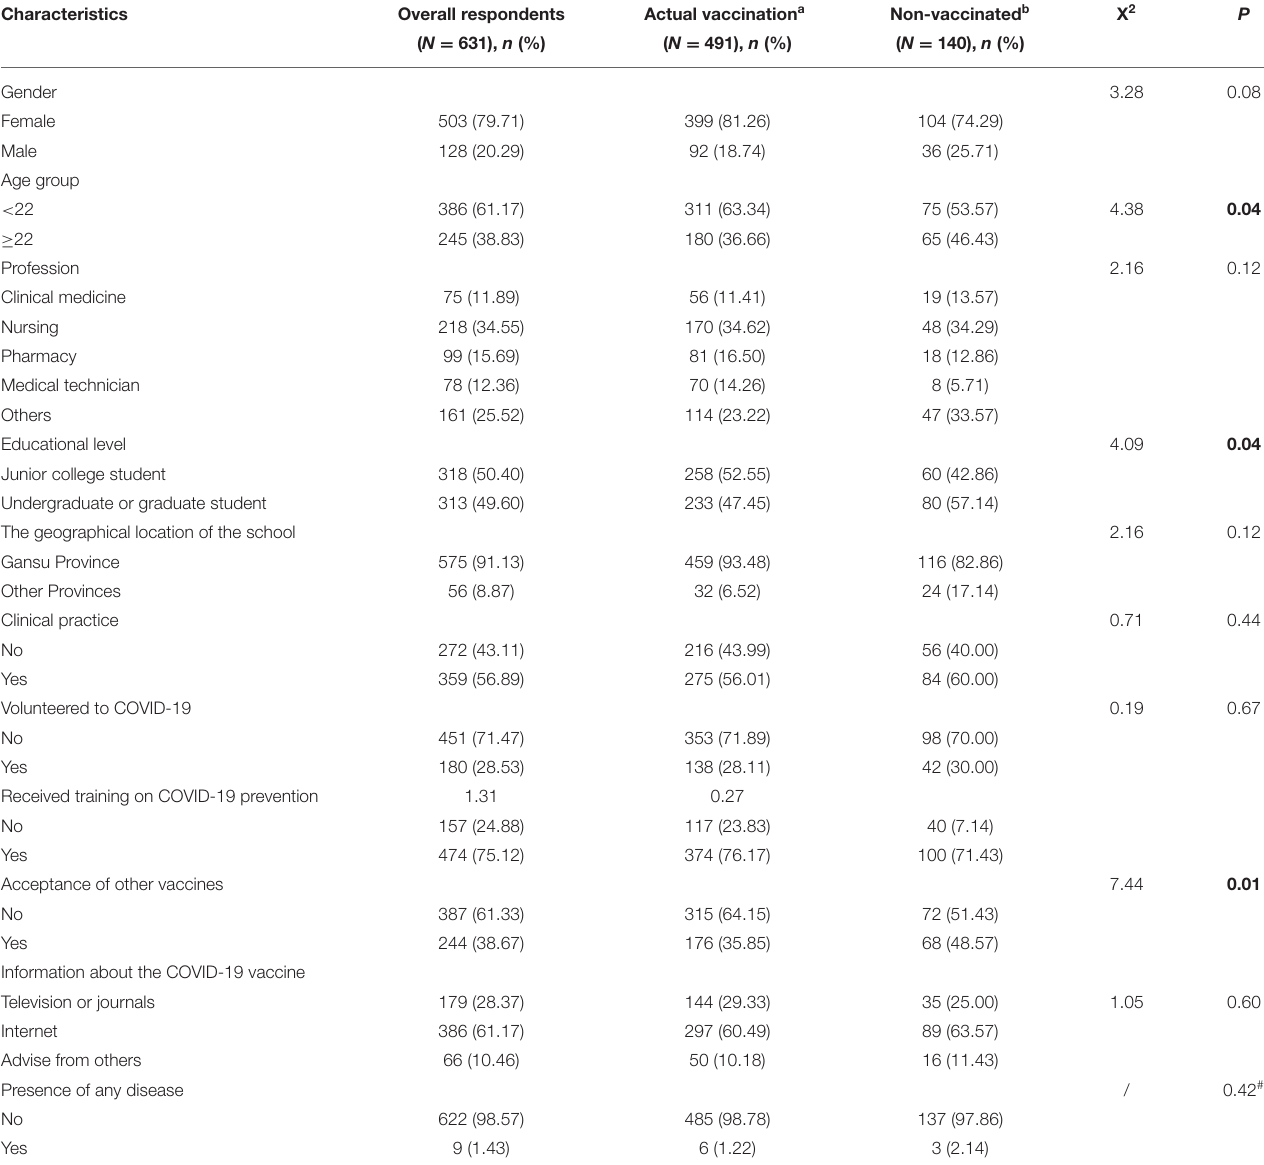
TABLE 1 | Demographic characteristics of health care